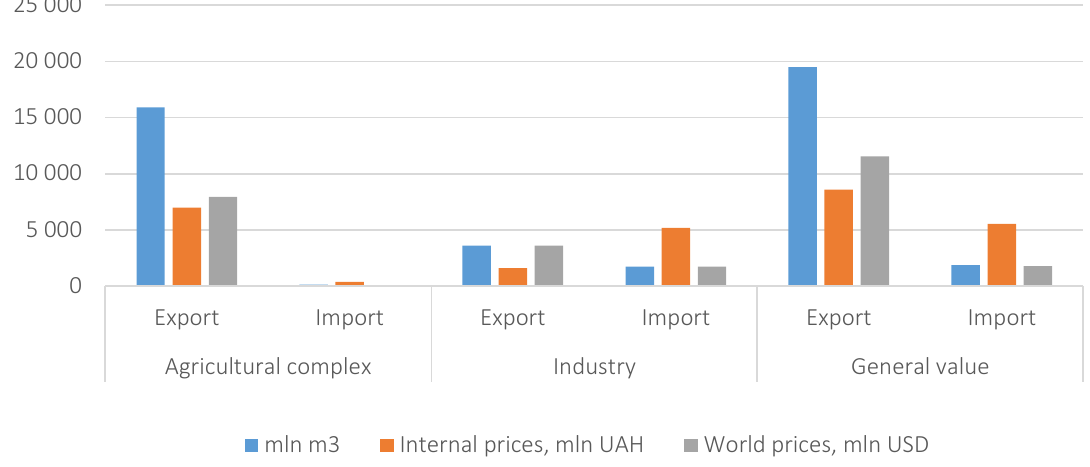
Figure 1. Export-import of virtual water and its characteristic for